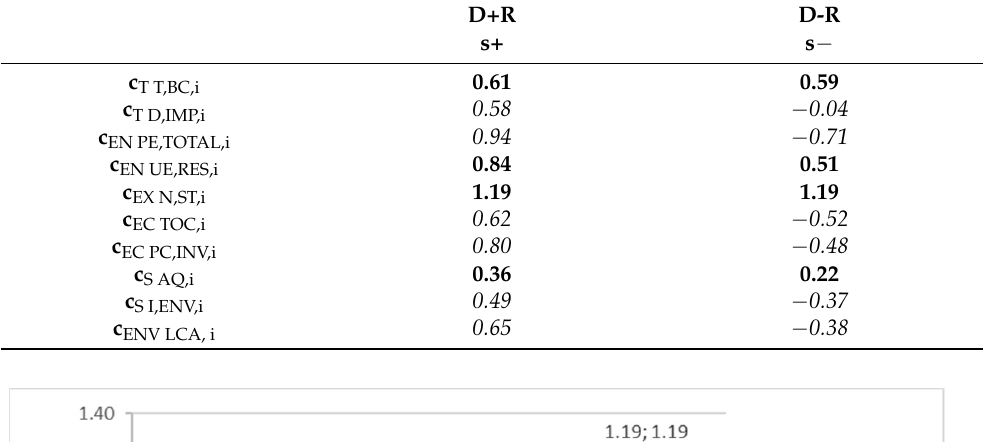
Table 2. The role and importance of individual main evaluation criteria.